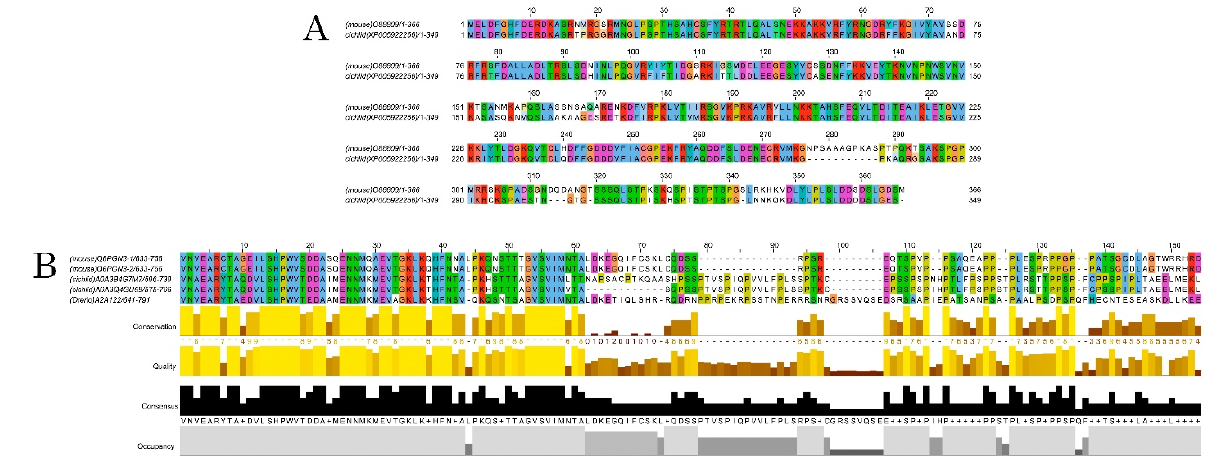
Figure 3. Alignments of DCX and DCLK amino acid sequences. Conserved residues between mice and A. burtoni DCX proteins ( A ); Conservation of the DCLK2 immunogen sequence use to detecting DCLK protein among the studied species ( B ).